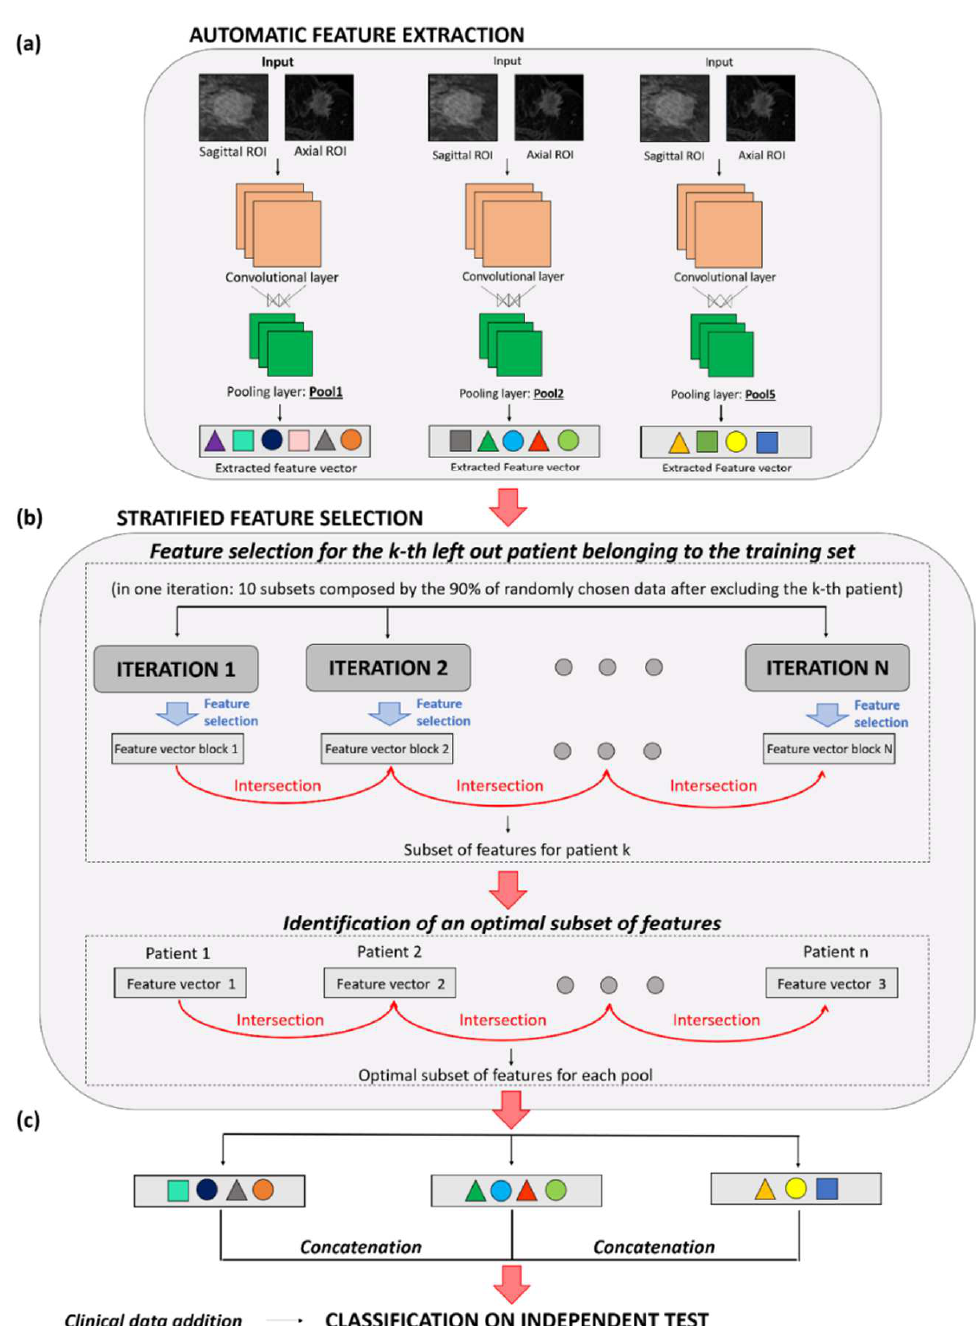
Figure 2. Workflow of the proposed AI framework for early pCR prediction. The approach consists of three main steps: ( a ) Automatic feature extraction through a pre-trained CNN; ( b ) Stratified feature selection; ( c ) Classification on the independent test. The method has been applied on sagittal and axial baseline MRIs